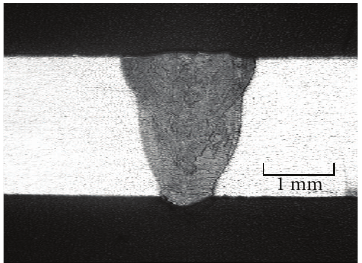
Figure 9: Cross section of AA6061 butt welded joint produced using P = 4kW, S = 6m/min, Dd = − 1 . 5 mm with filler wire.